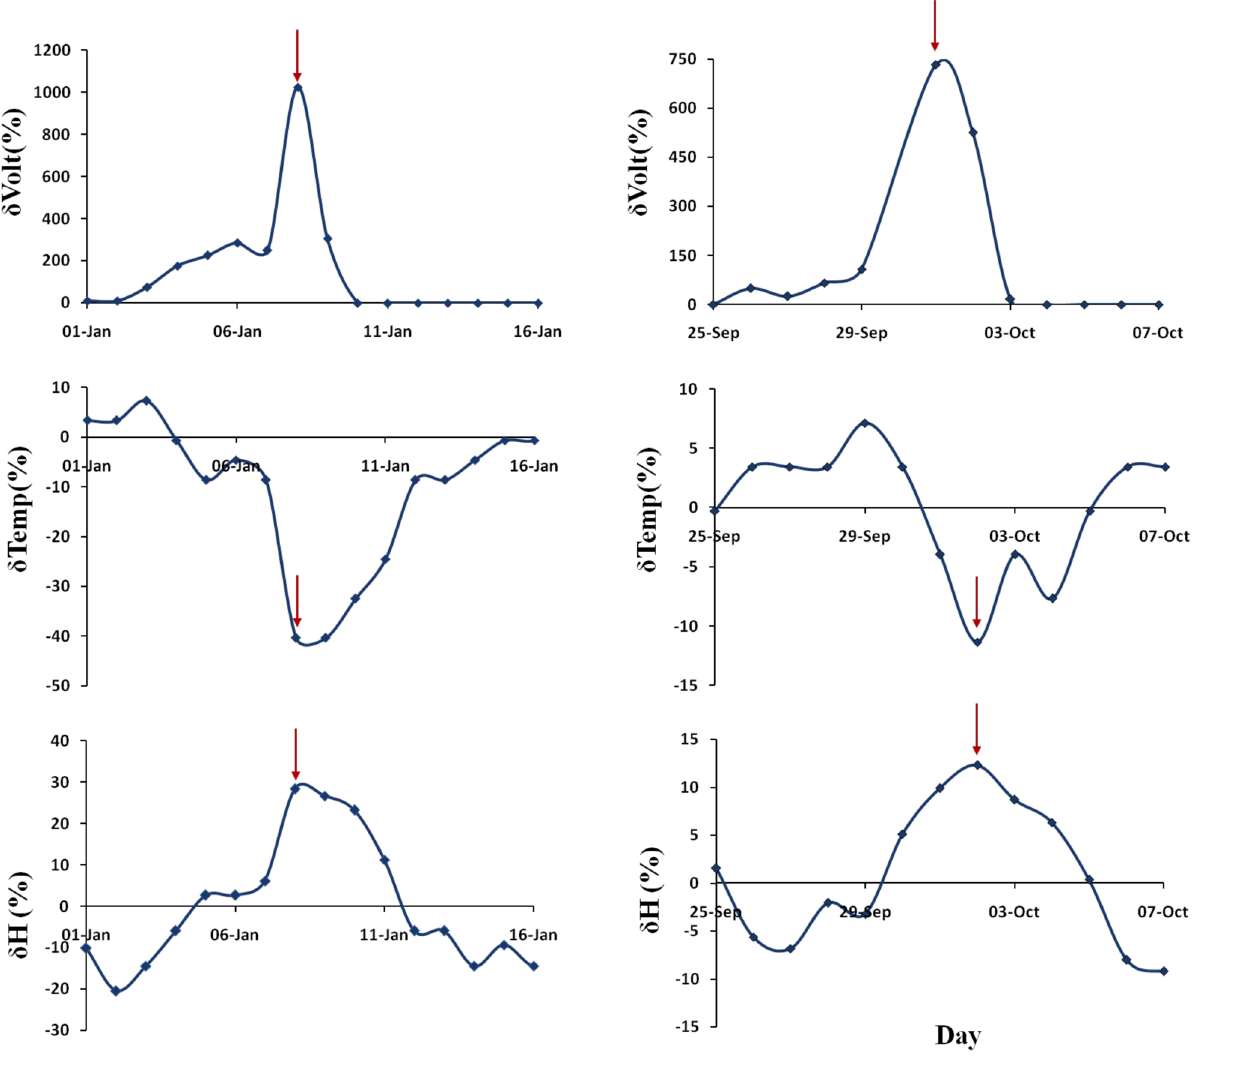
Figure 12. Percentage increase in magnitudes of over horizon sig- nal amplitudes (in volt) observed at GU for the days covering the October 1, 2012, EQ event, along with deviations of temperature, humidity from the average magnitude. Note that with the increase of signal strength by 700%, the humidity shows enhancement by 12%, in synchronization with the decrease of temperature by 10%. The red arrow marks the simultaneity between these